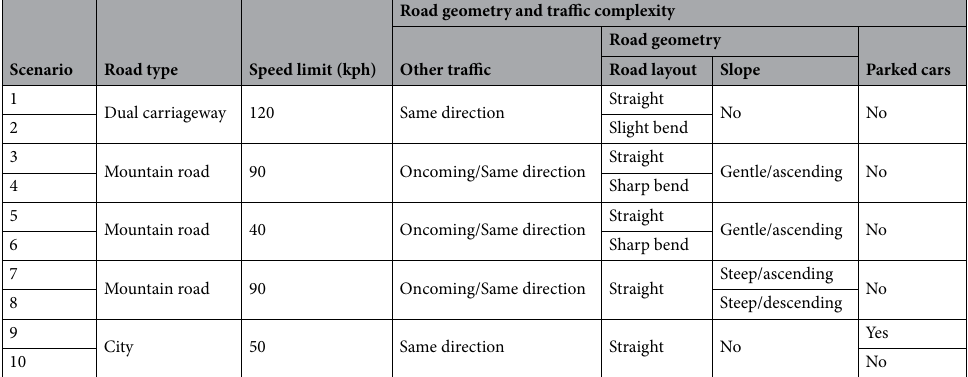
Table 1. Characteristics of the different driving scenarios used in the analysis.